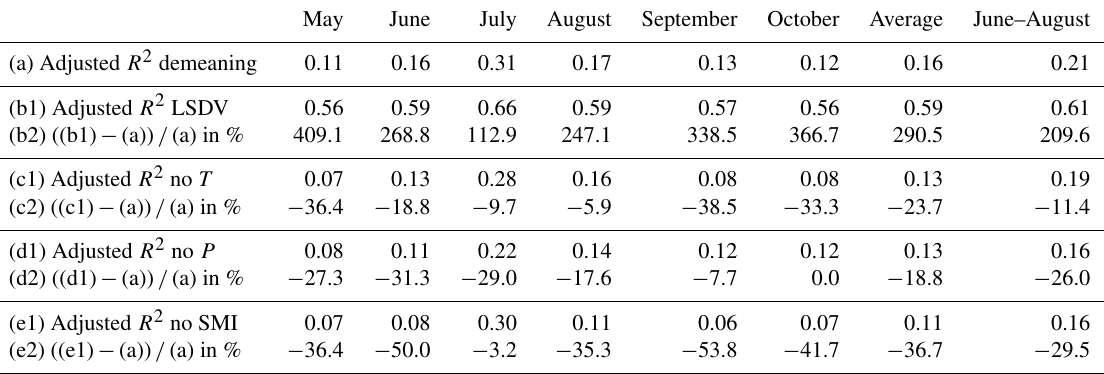
Table 3. Comparison of the adjusted coefficients of determination R 2 . The results from the demeaning framework serve as reference to the ones obtained by least-squares dummy variable regression (LSDV). The latter explicitly accounts for the fixed effects. Additionally, model configurations without either T , P , or SMI are